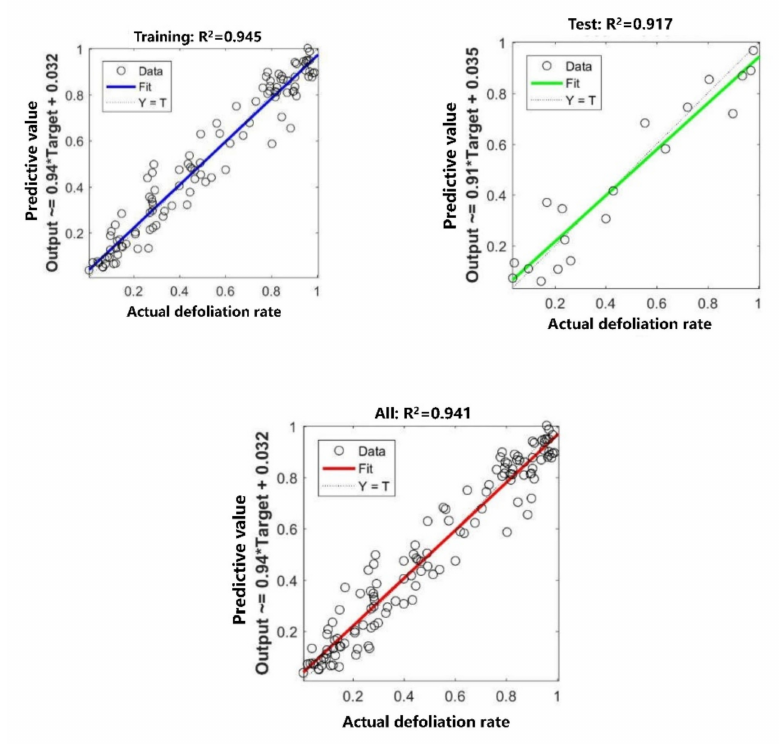
Figure 7. Neural network fitting